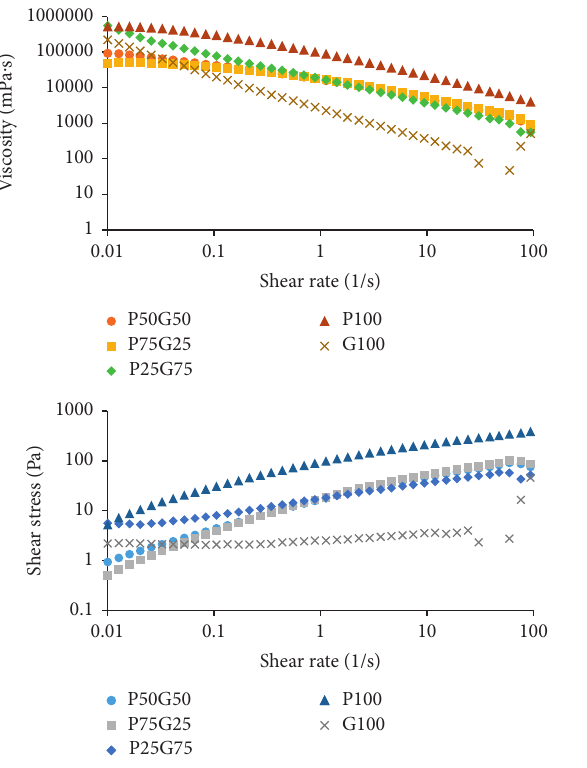
Figure 1: The effects of pectin: gum cordia ratio on apparent viscosity and shear stress of